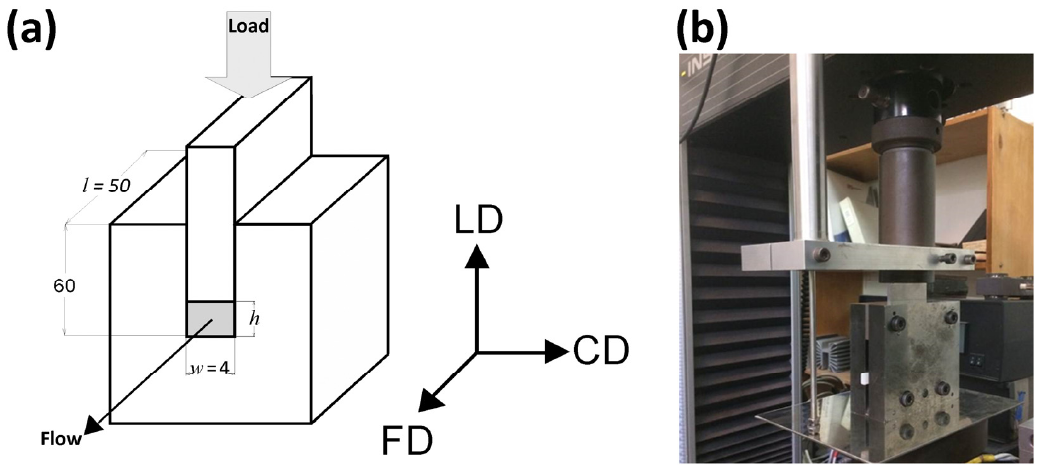
Figure 1. Schematic drawing ( a ) and a photograph ( b ) of the channel-die compression fixture.